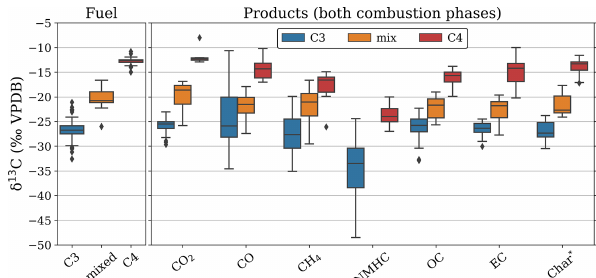
Figure 8. Representativeness of the stable carbon isotopic signa- ture of different biomass burning products for the precursor fuel. Left: signature range of the bulk fuel. Right: signature range of the biomass burning